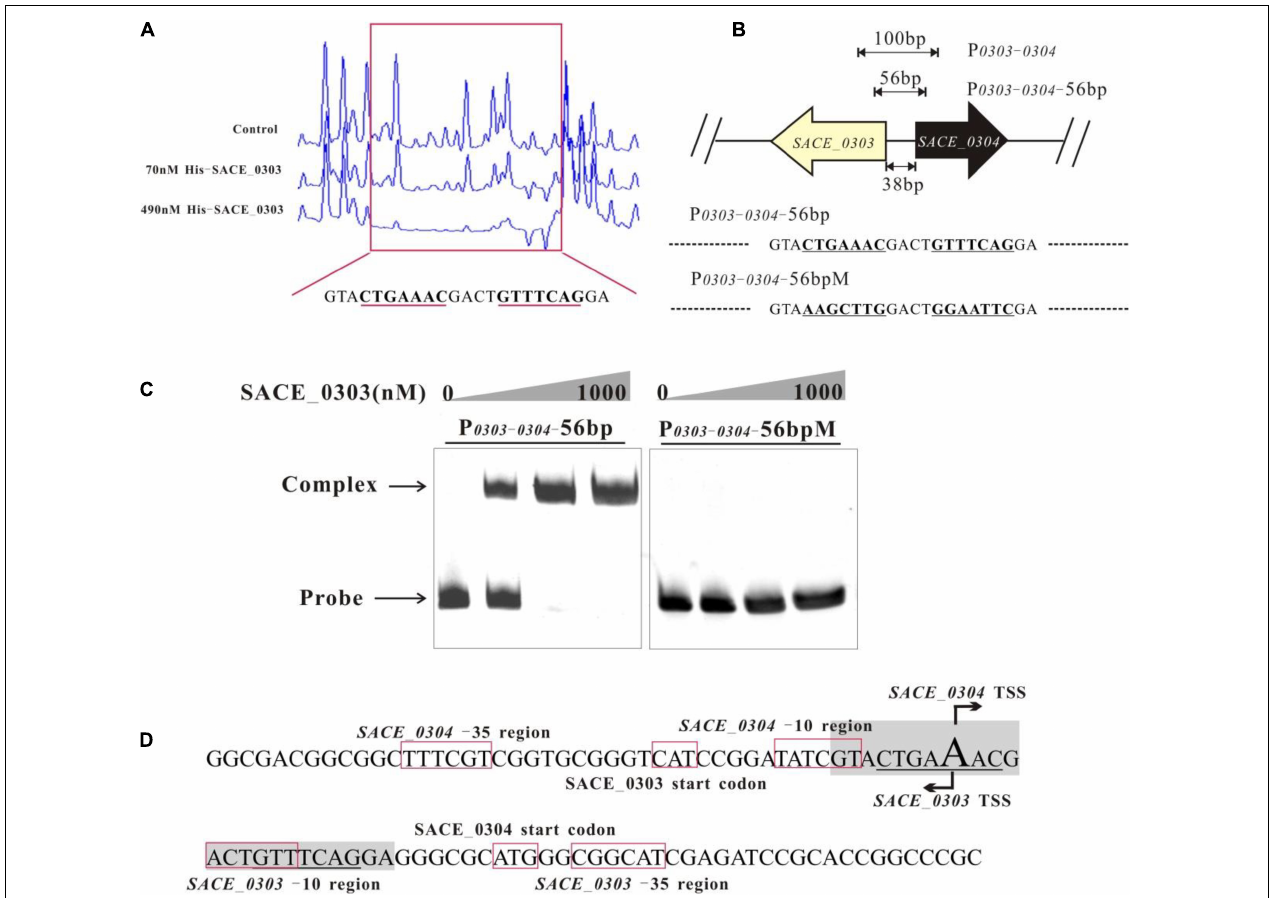
FIGURE 5 | Determination of the SACE_0303-binding sites. (A) DNase I footprinting assay of SACE_0303-binding site within P 0303 − 0304 . Upper fluorogram: control reaction without protein. Protection regions were acquired with increasing concentrations (70 and 490 nM) of His6- SACE_0303. (B) Different probes designed for determining DNA binding site of SACE_0303. (C) Binding assays of SACE_0303 to P 0303 − 0304 - 56 bp and P 0303 − 0304 - 56 bpM. (D) Nucleotide sequences of promoter regions of SACE_0303 and SACE_0304 . Transcriptional start site,